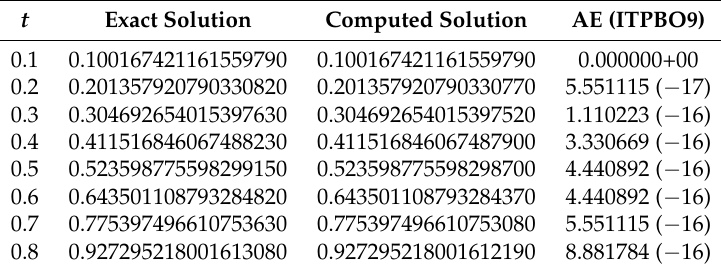
Table 5. Numerical findings for solving Problem 3, h = 0.01.